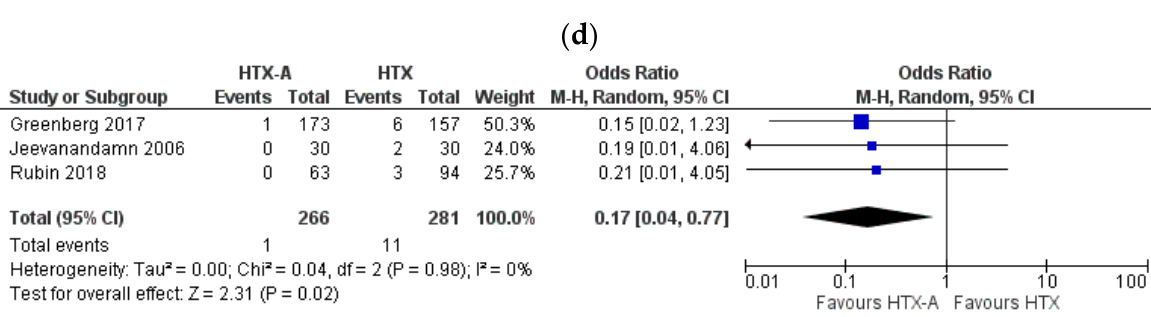
Figure 2. Forest plot depicting post-transplantation TR: ( a ) immediate; ( b ) after 1 week; ( c ) after 6 months; ( d ) after 1 year.